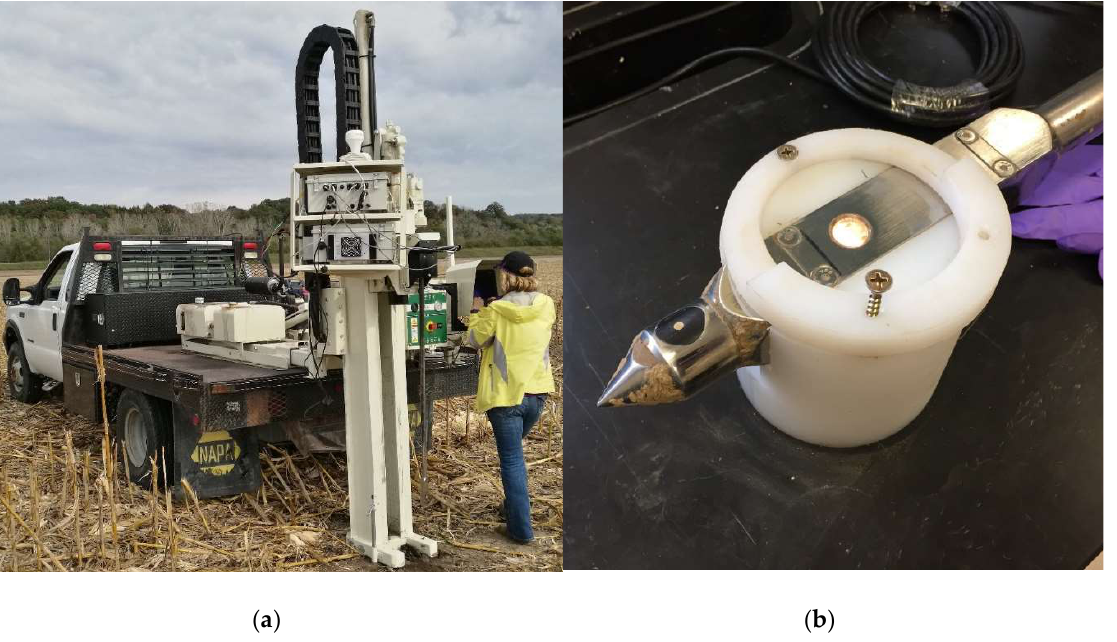
Figure 1. The Veris P4000 VIS-NIR instrument ( a ) and close-up view of the P4000 probe tip adapted for the laboratory ( b